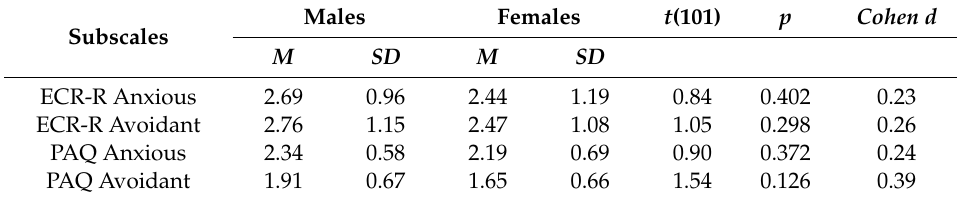
Table 2. Results of Comparisons of Gender on Subscale Variables of Attachment. Subscales